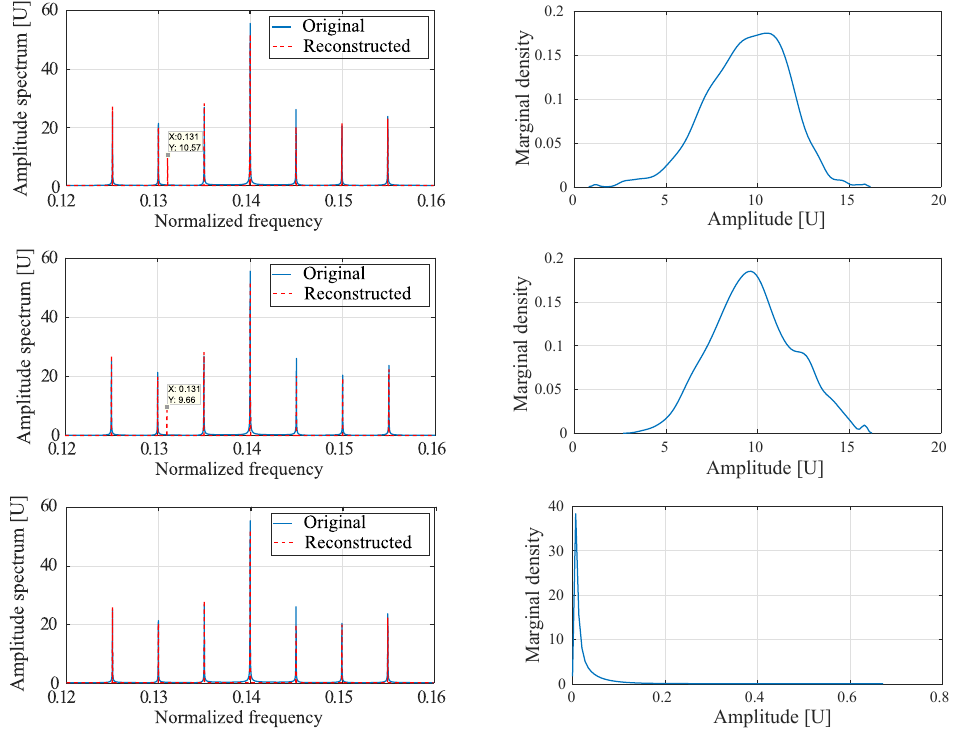
Figure 7. Zoom on spectra around the interfering component (left) and marginal density for co- efficient related to the interfering component using models (from top to bottom): t-univ, H-univ, and